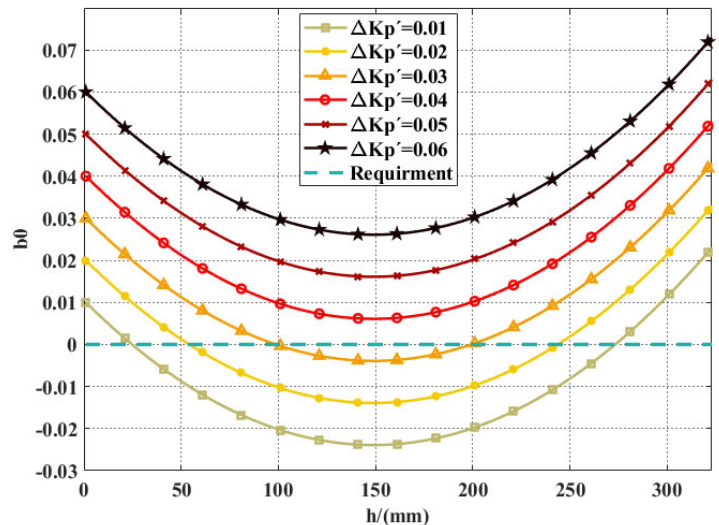
Figure 12. The variation of b (cid:2868) as a function of h at different upper limits of propeller regulation.